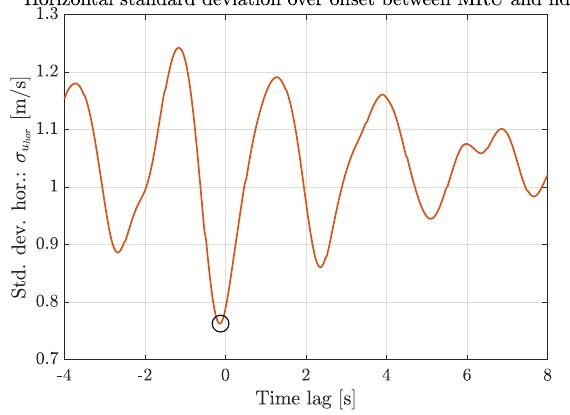
Figure 4. Standard deviation of the motion compensated horizontal wind speed σ u of timing offset between MRU and lidar data. σ u ten-minute interval. The absolute minimum at − 0.16s indicates the sweet spot that corresponds to the real offset between the two